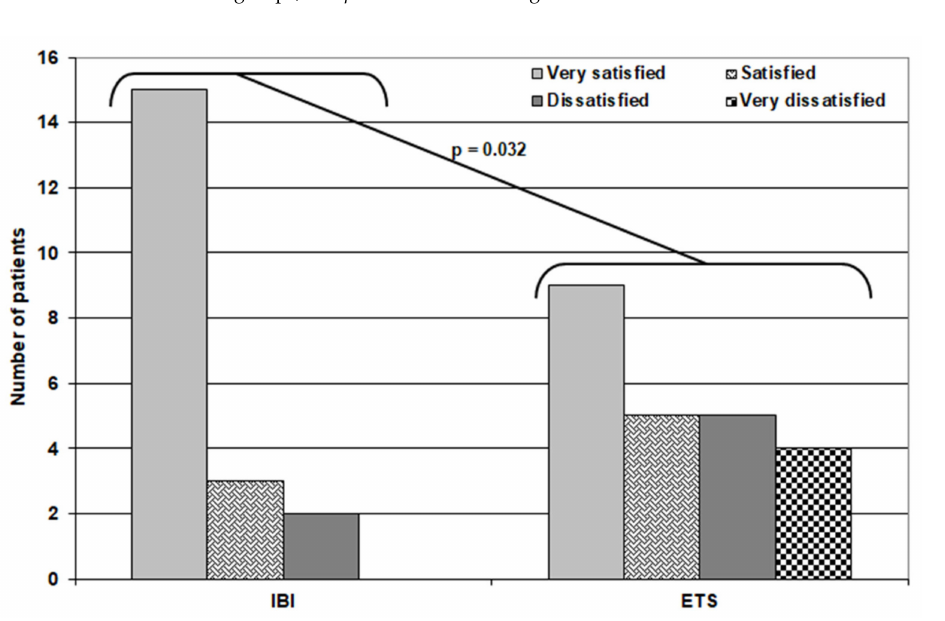
Figure 4. Distribution of patients of both groups according to their satisfaction